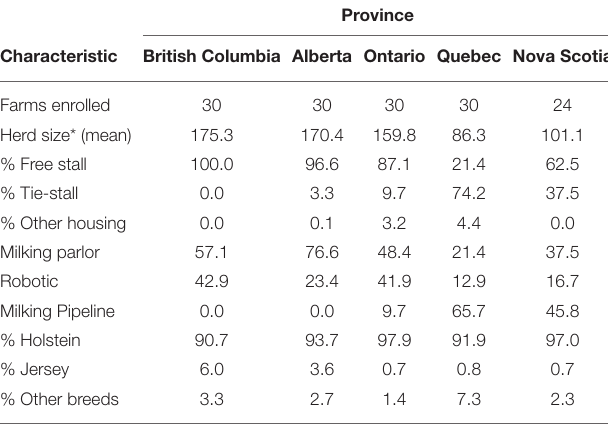
TABLE 1 | Summary of demographic information from dairy farms enrolled in CaDNetASR during 2019 and 2020.